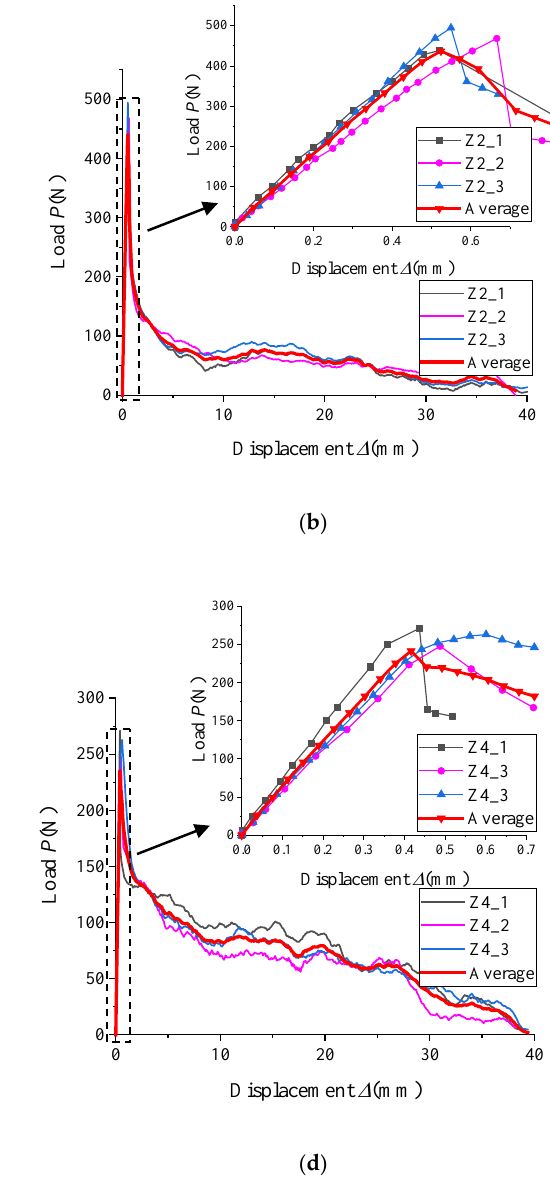
Figure 3. Pullout P - ∆ curves: steel fibres treated by four silane-based coupling agents (group Z): ( a ) Z1: Z6011; ( b ) Z2: Z6020; ( c ) Z3: Z6030; ( d ) Z4: Z6040.